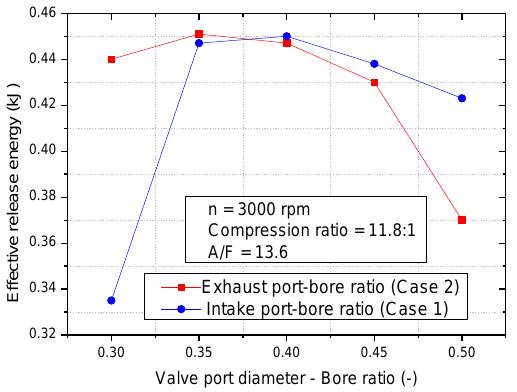
Figure 15. E ff ective release energy versus VPD / Figure 15. Effective release energy versus VPD/B.